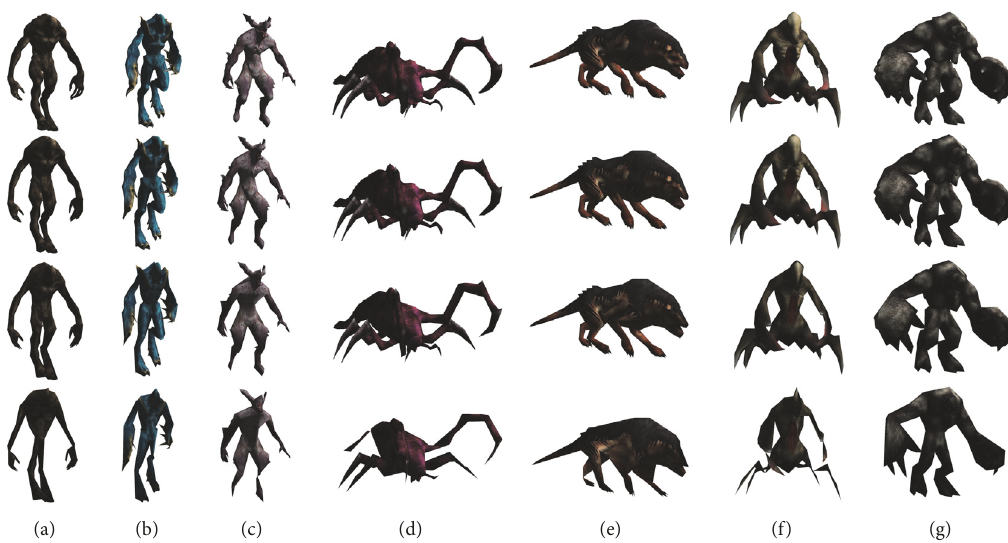
Figure 2: The examples showing different levels of detail for seven source characters. From top to bottom, the numbers of triangles are as follows: (a) Alien: 5,688, 1,316, 601, and 319; (b) Bug: 6,090, 1,926, 734, and 434; (c) Daemon: 6,652, 1,286, 612, and 444; (d) Nasty: 6,848, 1,588, 720, and 375; (e) Ripper Dog: 4,974, 1,448, 606, and 309; (f) Spider: 5,868, 1,152, 436, and 257; (g) Titan: 6,518, 1,581, 681, and